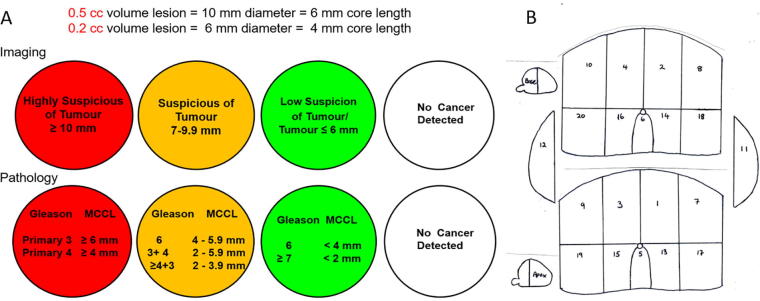
Schematic representation of (A) imaging and pathological traffic light classification and (B) delineate-modified Barzell zones (see Supplemental Appendix B).